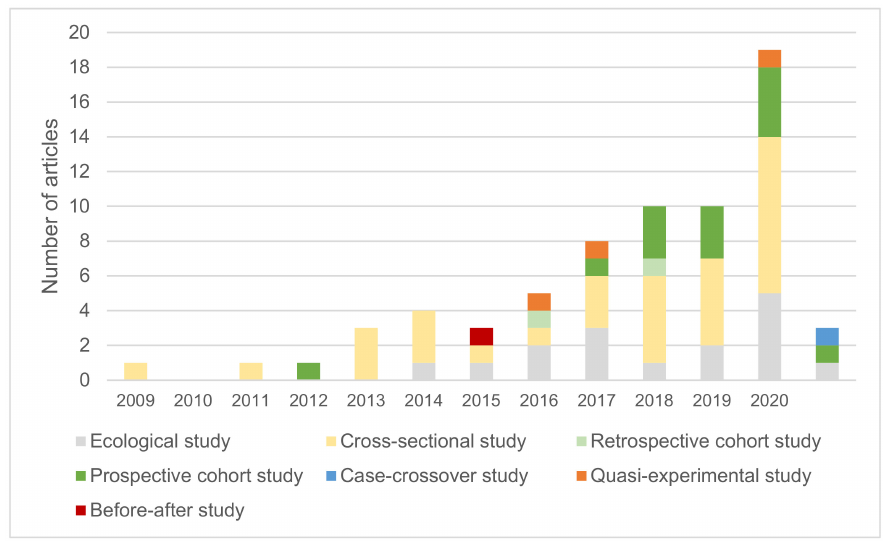
Figure 2. Published studies over the years, by study